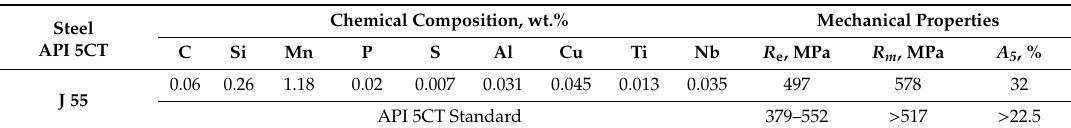
Table 1. Chemical composition and mechanical properties of microalloyed steel API 5CT J55 in the direction of rolling.